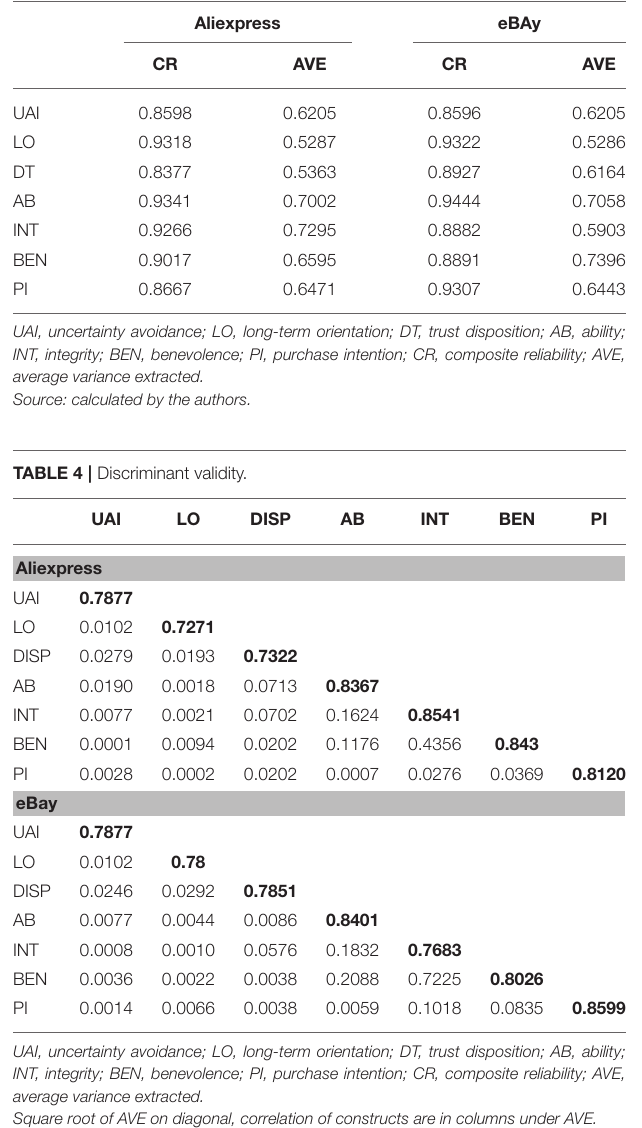
TABLE 3 | Construct validity and reliability.